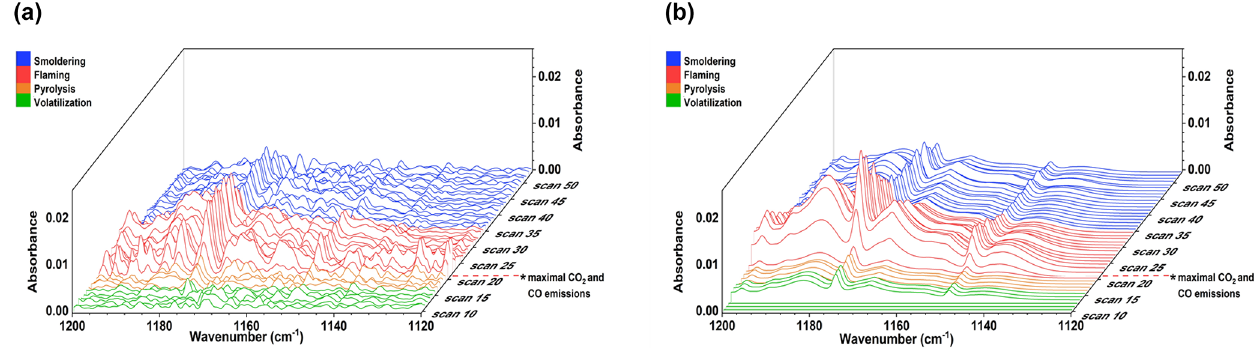
Figure 6. Burn 87 – longleaf pine needles with an inkberry fuel bed during the dynamic mode. Measured and scaled burn spectra showing the progression of phenol during the time-resolved study. Acetic acid and water spectral features have been removed in (a) , with the phenol-only derived mixing ratio spectra in (b)